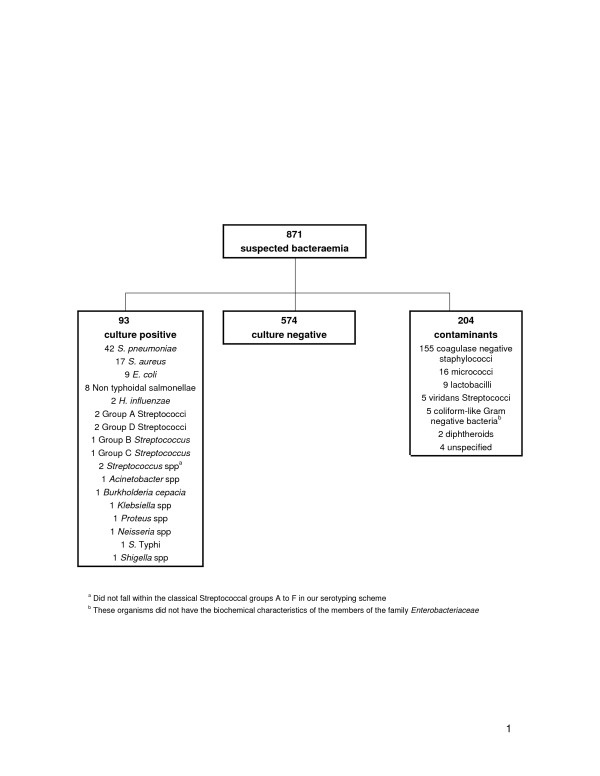
Flow diagram of suspected bacteraemia patients according to blood culture results.